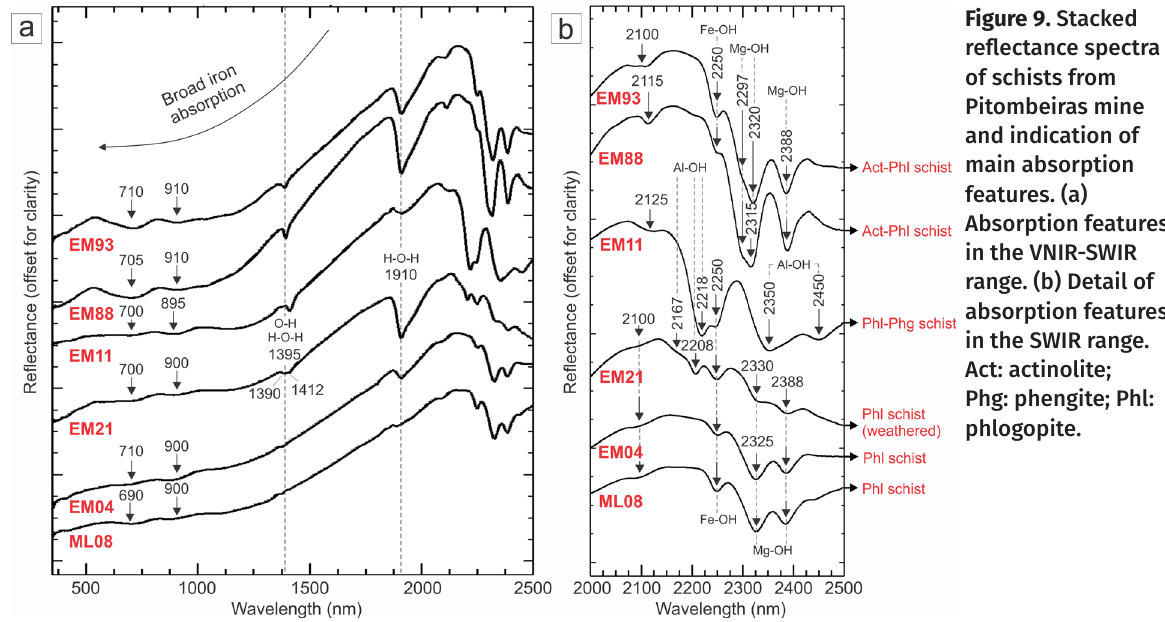
Figure 9. Stacked reflectance spectra of schists from Pitombeiras